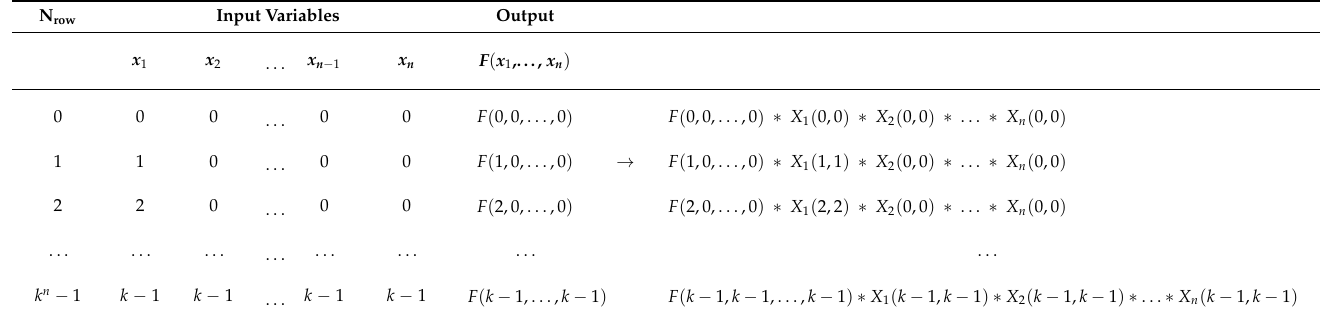
Table 1. Truth table of a MVL function with equivalent product terms for rows with nonzero output